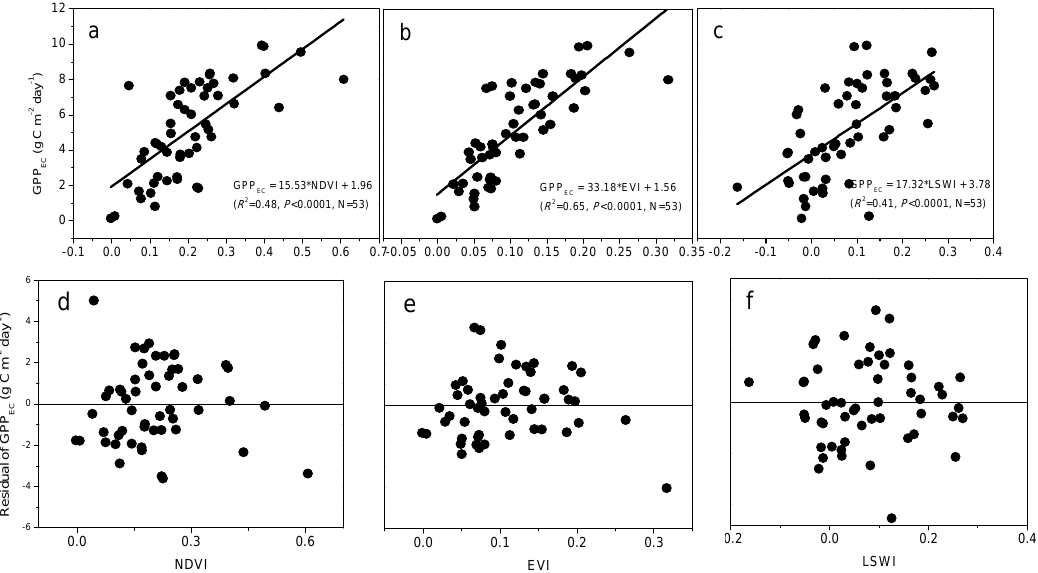
Figure 5. Linear relationships between ( a , d ) Normalized Difference Vegetation Index (NDVI); ( b , e ) Enhanced Vegetation Index (EVI); ( c , f ) Land Surface Water Index (LSWI) and estimated gross primary production (GPP) from EC tower data (GPP EC ) during 2009–2010. Dashed lines are the linear trends of NDVI, EVI, LSWI, and GPP EC , respectively.